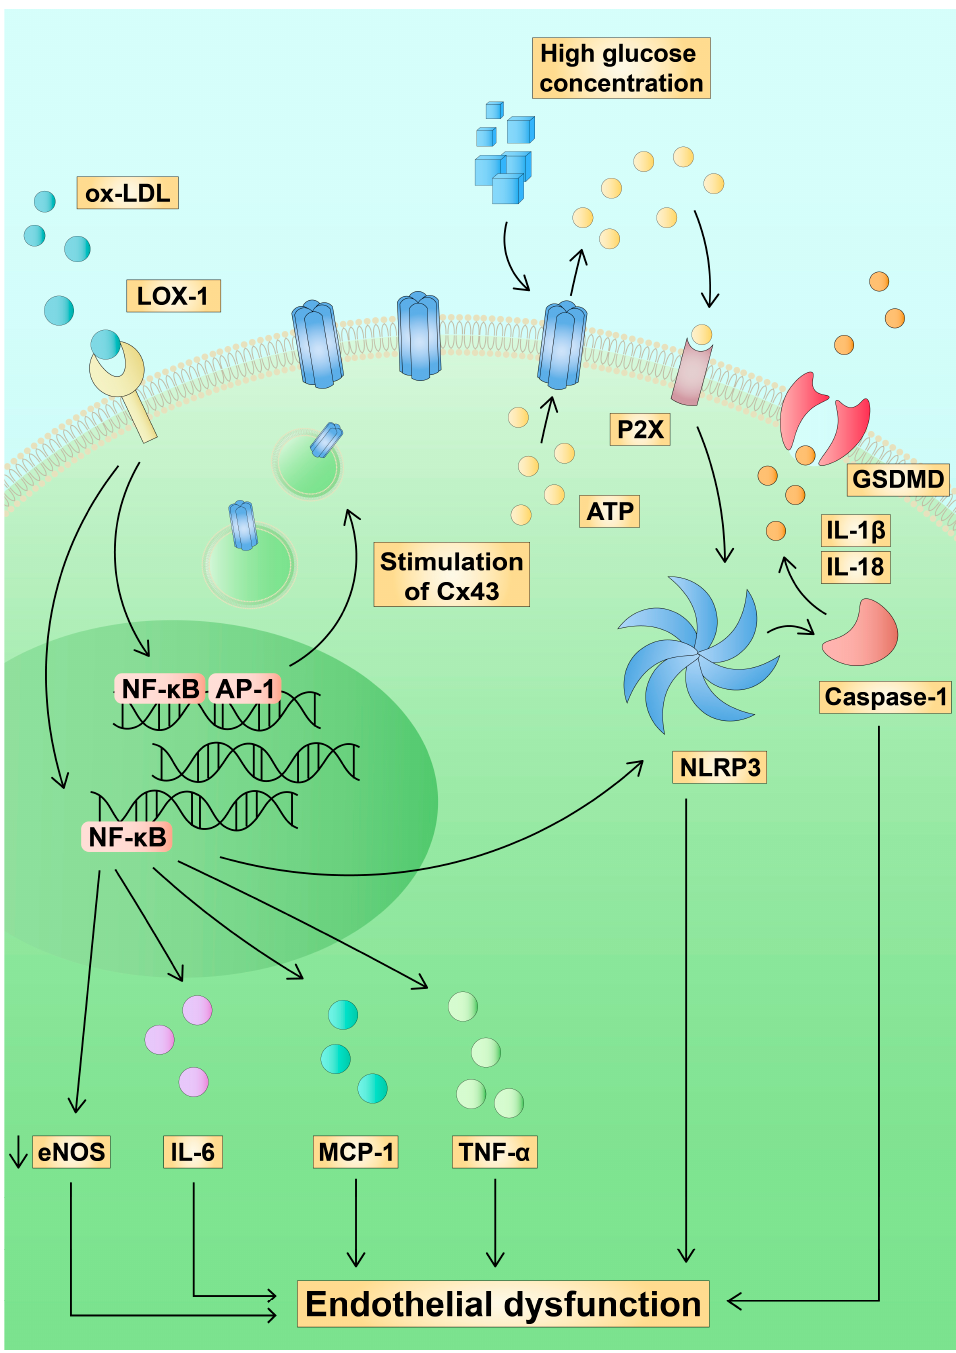
Figure 4. Hypothetical impact of Cx43 on endothelial dysfunction. Ox-LDL-induced activation of NF- κ B leads to Cx43 upregulation. Ox-LDL and high glucose concentration contribute to Cx43